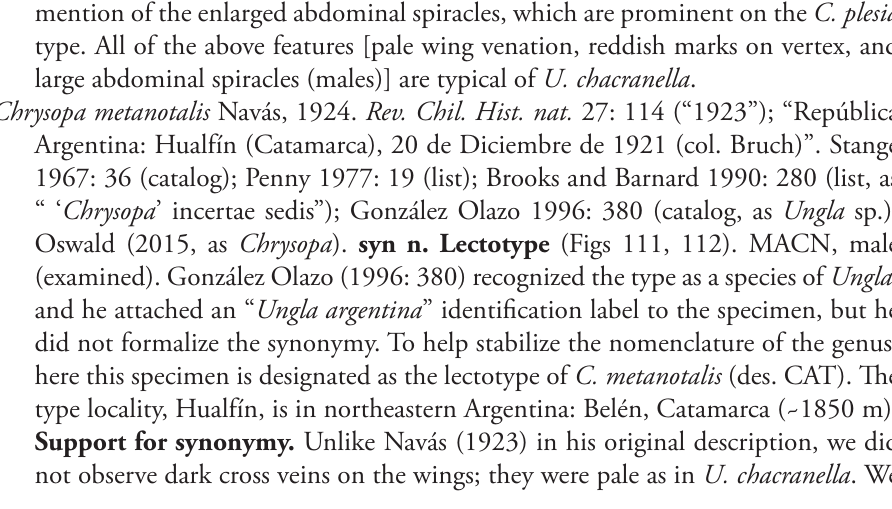
ally, which are not present on the C. binaria type. It is surprising that he made no mention of the enlarged abdominal spiracles, which are prominent on the C. plesia type. All of the above features [pale wing venation, reddish marks on vertex, and large abdominal spiracles (males)] are typical of U. chacranella